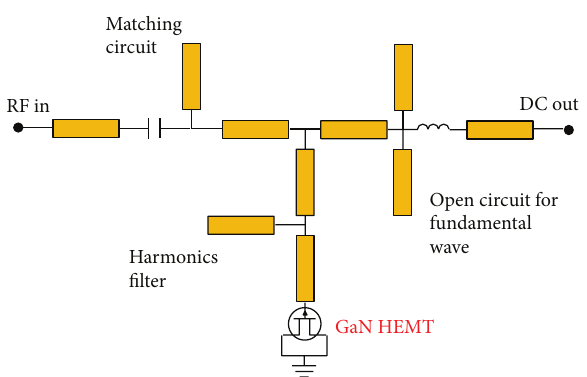
Figure 14: A circuit of the S-band high-power rectifier.